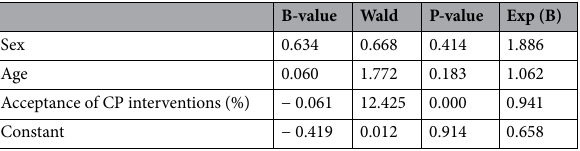
Table 4. Logistic regression analysis of treatment guidelines adherence for antidepressants.